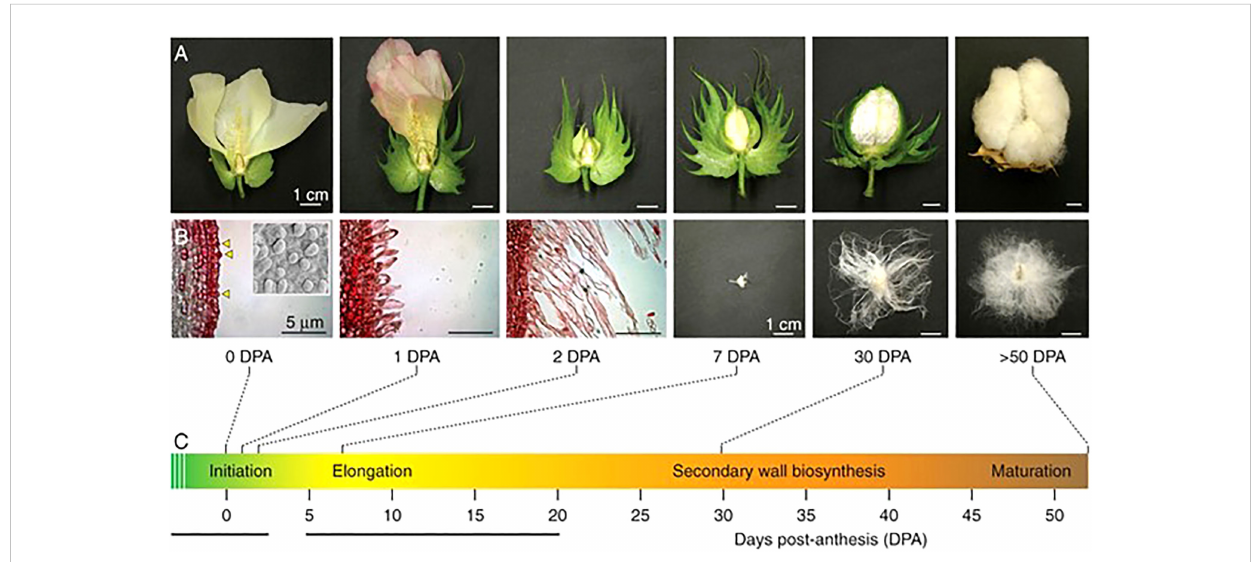
Figure 1 A model of Gossypium evolution. Approximately 1 mya, divergent A and D lineages hybridized and underwent genome doubling, resulting in the allotetraploid AD clade. This clade diversi fi ed into seven polyploid species, two of which underwent domestication and